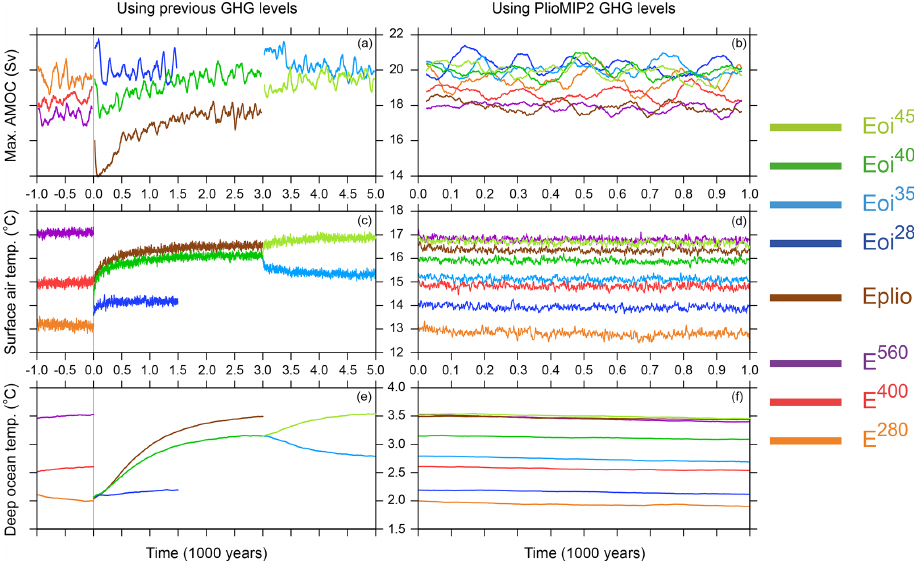
Figure 2. Time series of the AMOC index (a, b) , globally averaged surface air temperature (c, d) and global ocean temperature below depths of 1900m (e, f) . A 51-year moving average has been applied to the AMOC index time series. The panels on the left depict the initial stages of the experiments during which greenhouse gas levels are set to previous, PlioMIP1 values, while the panels on the right depict the final 1000 years of the integration during which greenhouse gas levels are consistent with those specified in PlioMIP2.